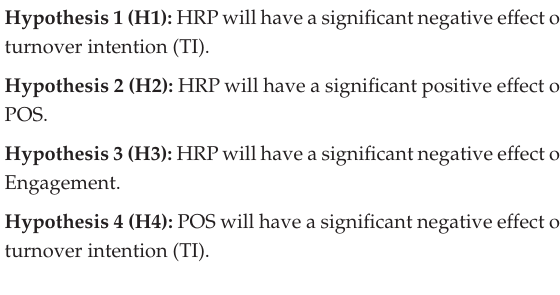
TABLE 2: Relationship between perceived organisation support and engagement. Author(s)